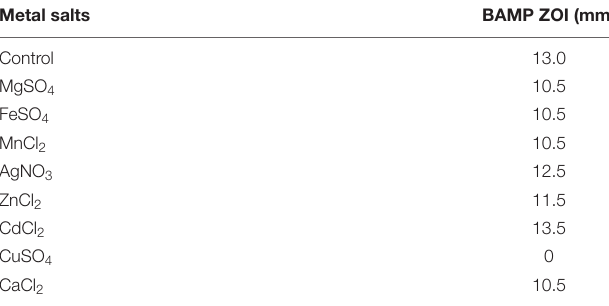
TABLE 2C | Effect of food-grade metal salts on the activity of